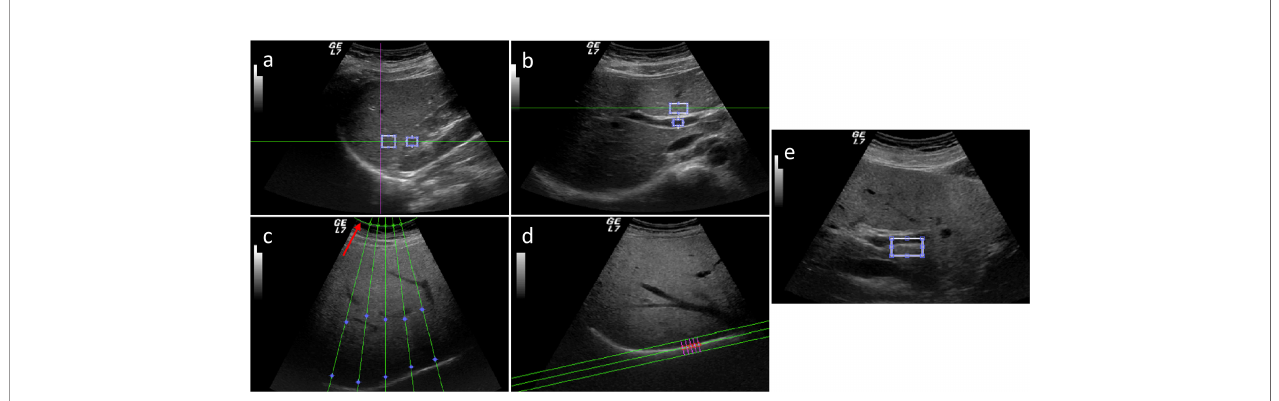
FIGURE 2 | Five parameters obtained by semi-automatically processed US images: hepatic – renal ratio (HR) (A) , hepatic portal vein (HPV) ratio (B) , attenuation rate (AR) (C) , diaphragm visualization (DV) (D) , and portal vein wall (PVW)